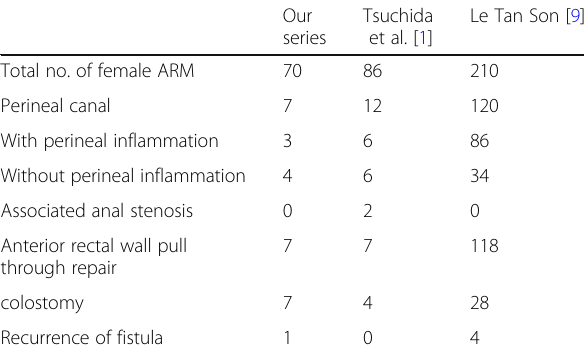
Table 3 Tsuchida ’ s technique/modified (anterior rectal wall pull through) technique of perineal canal repair